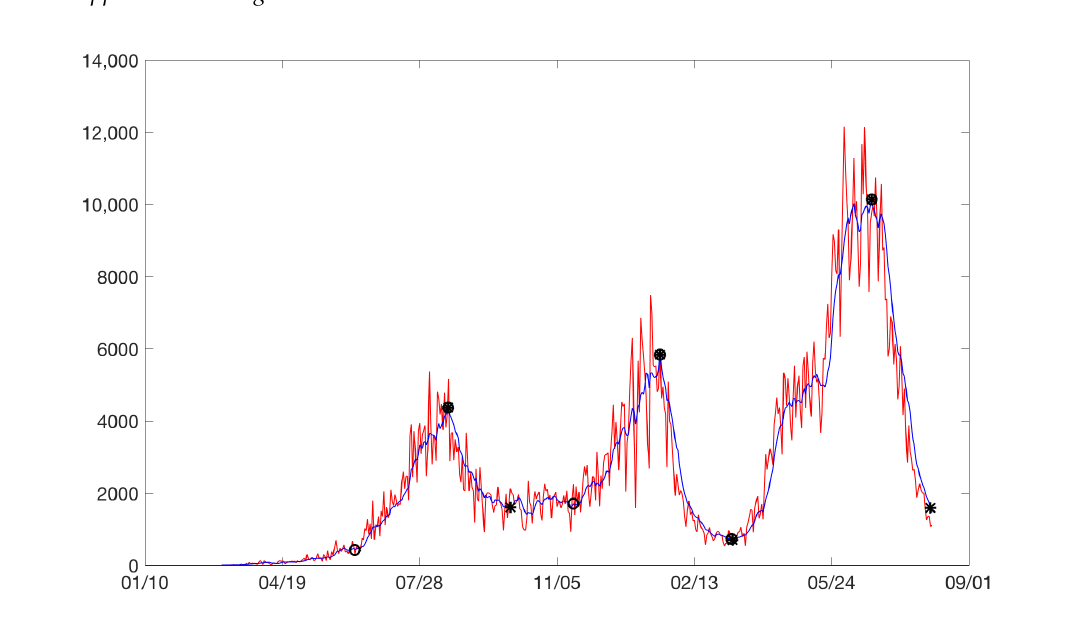
Figure A1. Bogota: on the horizontal axis is the date in days and on the vertical axis are the daily